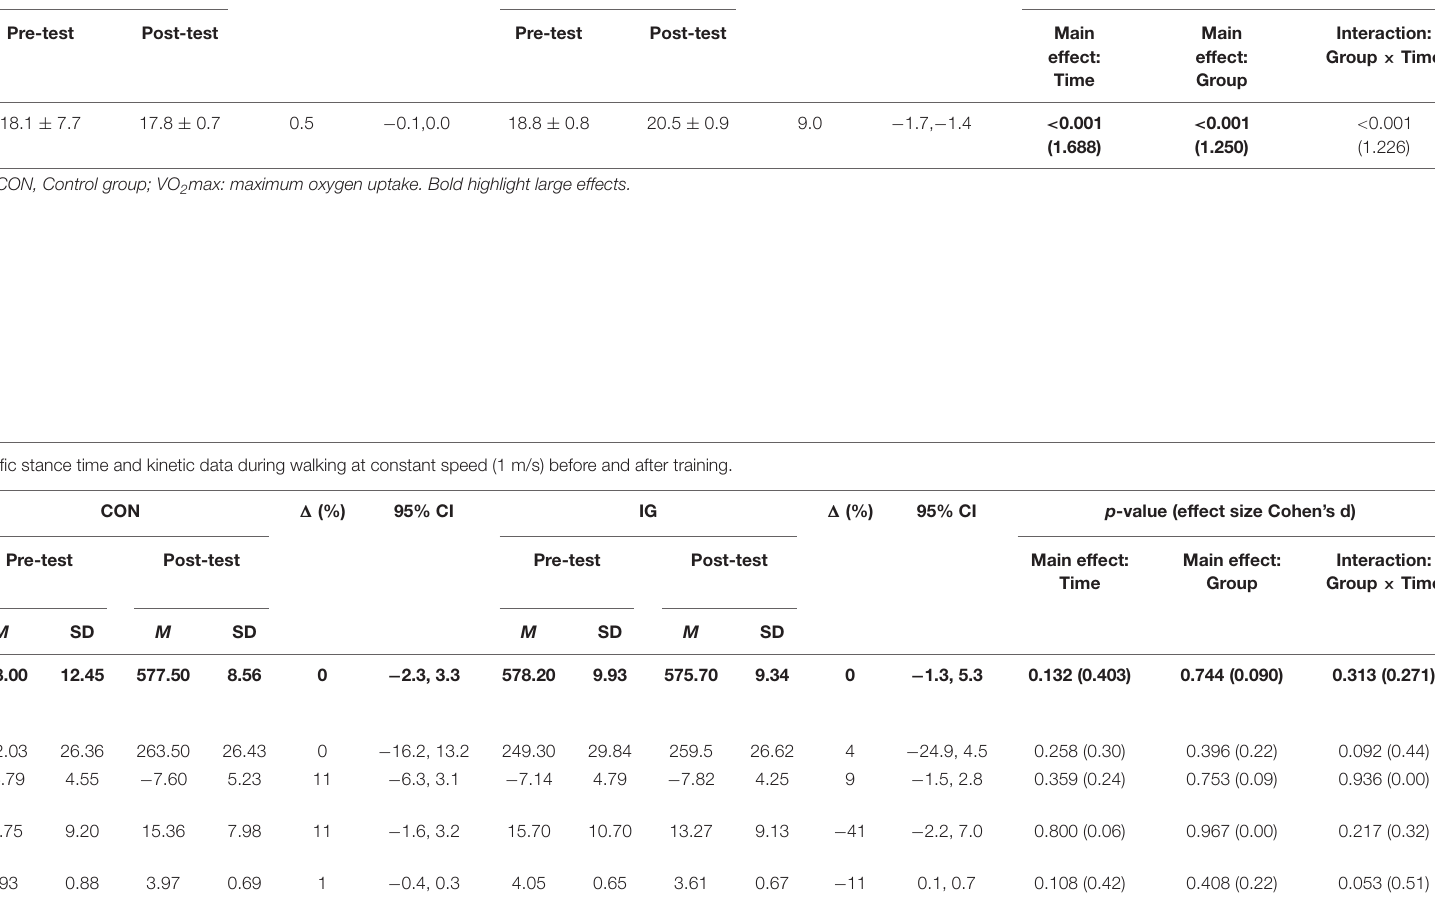
TABLE 4 | Group-specific VO2max data before and after training. Parameter CON (cid:49) (%) 95% CI Pre-test Post-test Pre-test Post-test Main